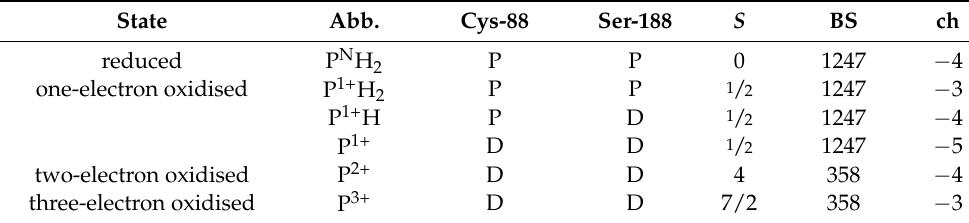
Table 1. The various states studied for the P-cluster. The table lists an abbreviation (Abb.) for each state, the protonation status for Cys-88 and Ser-188D (P = protonated, D = deprotonated), the spin state ( S ), the BS state (specifying Fe ions with minority spin) and the net charge of the QM systems (ch; same for both for QM/MM and for the redox calculations). State